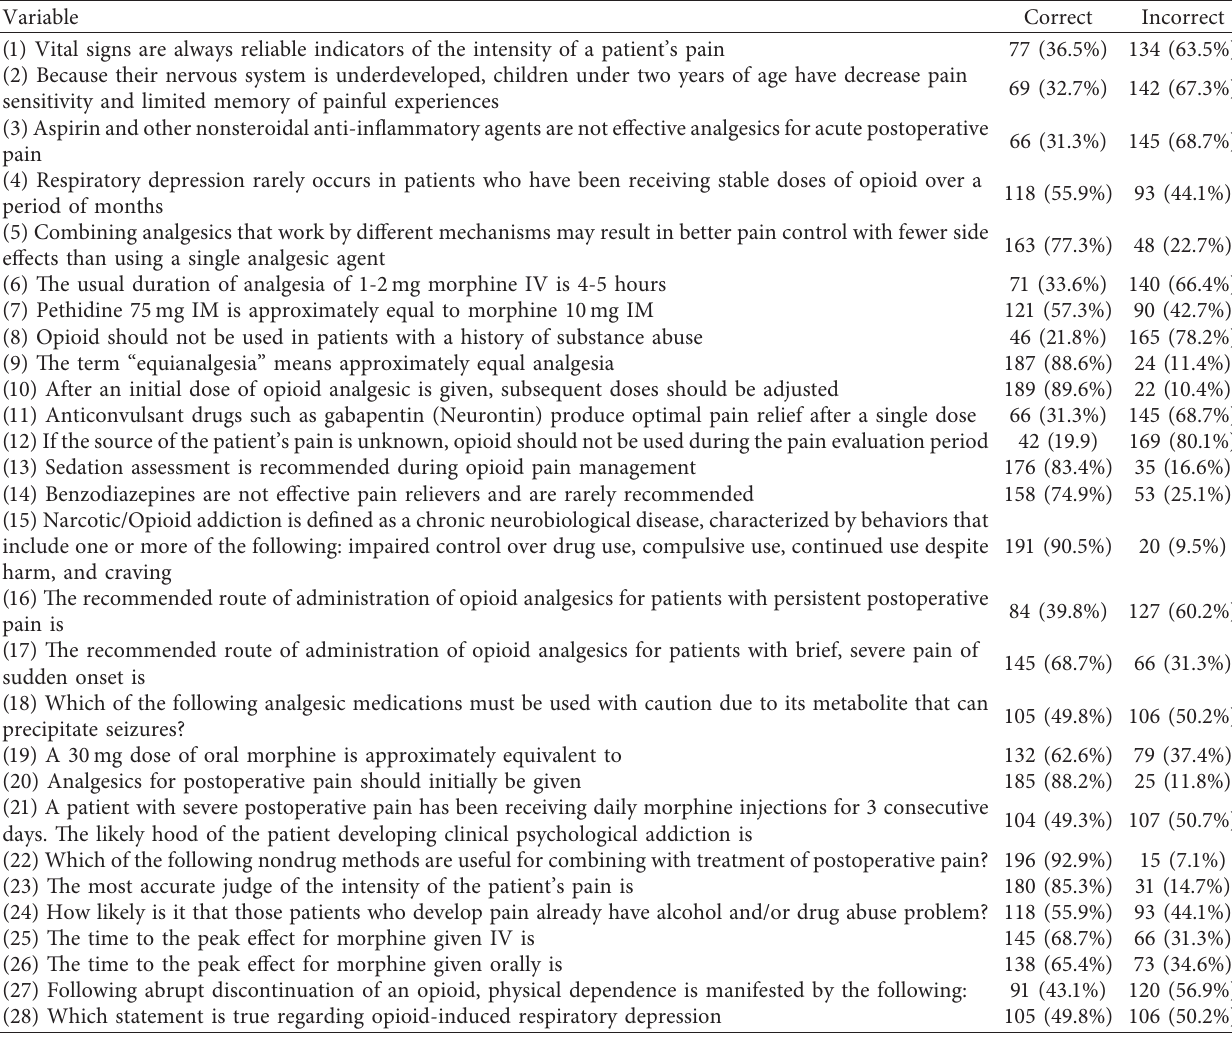
Table 2: Knowledge of pain management